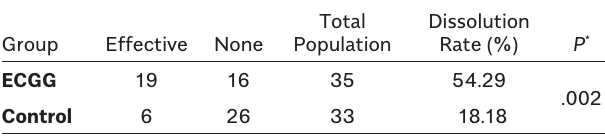
*Based on the chi-square test. ECGG, endothelium corneum gigeriae